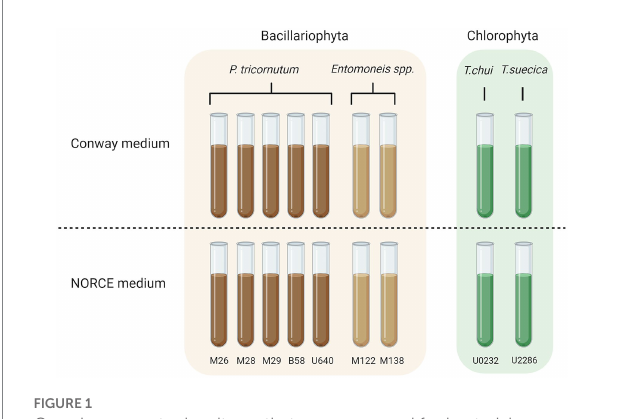
FIGURE 1 Overview over stock cultures that were screened for bacterial community composition. All strains were kept in two different media (Conway and NORCE) for different time periods before sampling. Figure created with